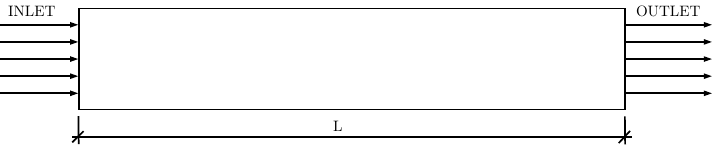
Figure 1. Morsi - Alexander Case Setup Figure 1. Morsi–Alexander Case Setup.